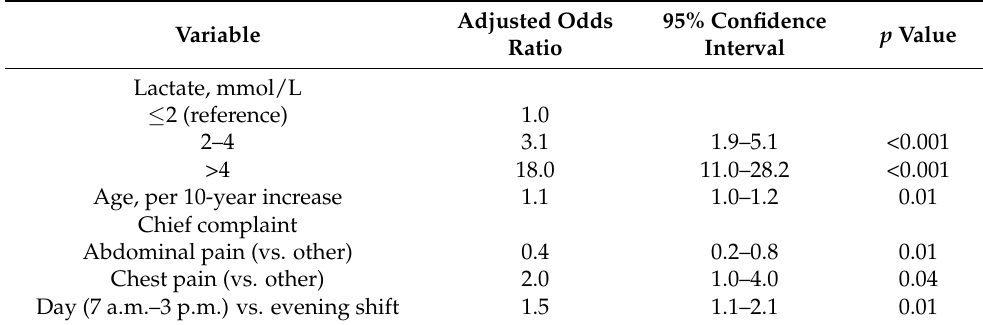
Table 3. Multivariable model of factors associated with emergency department-based in-hospital cardiac arrest.